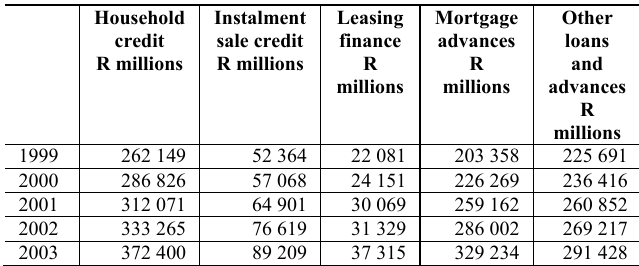
Table 1: South African household